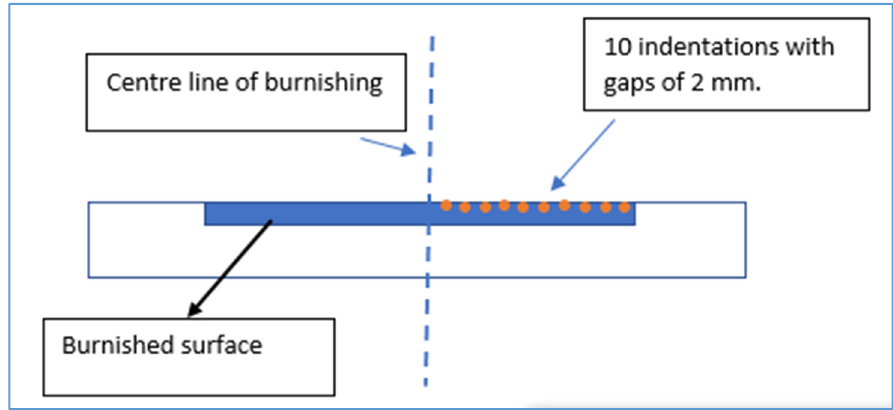
Figure 2. Cross-sectional view indicating the locations of indentations taken for microhardness evaluation.